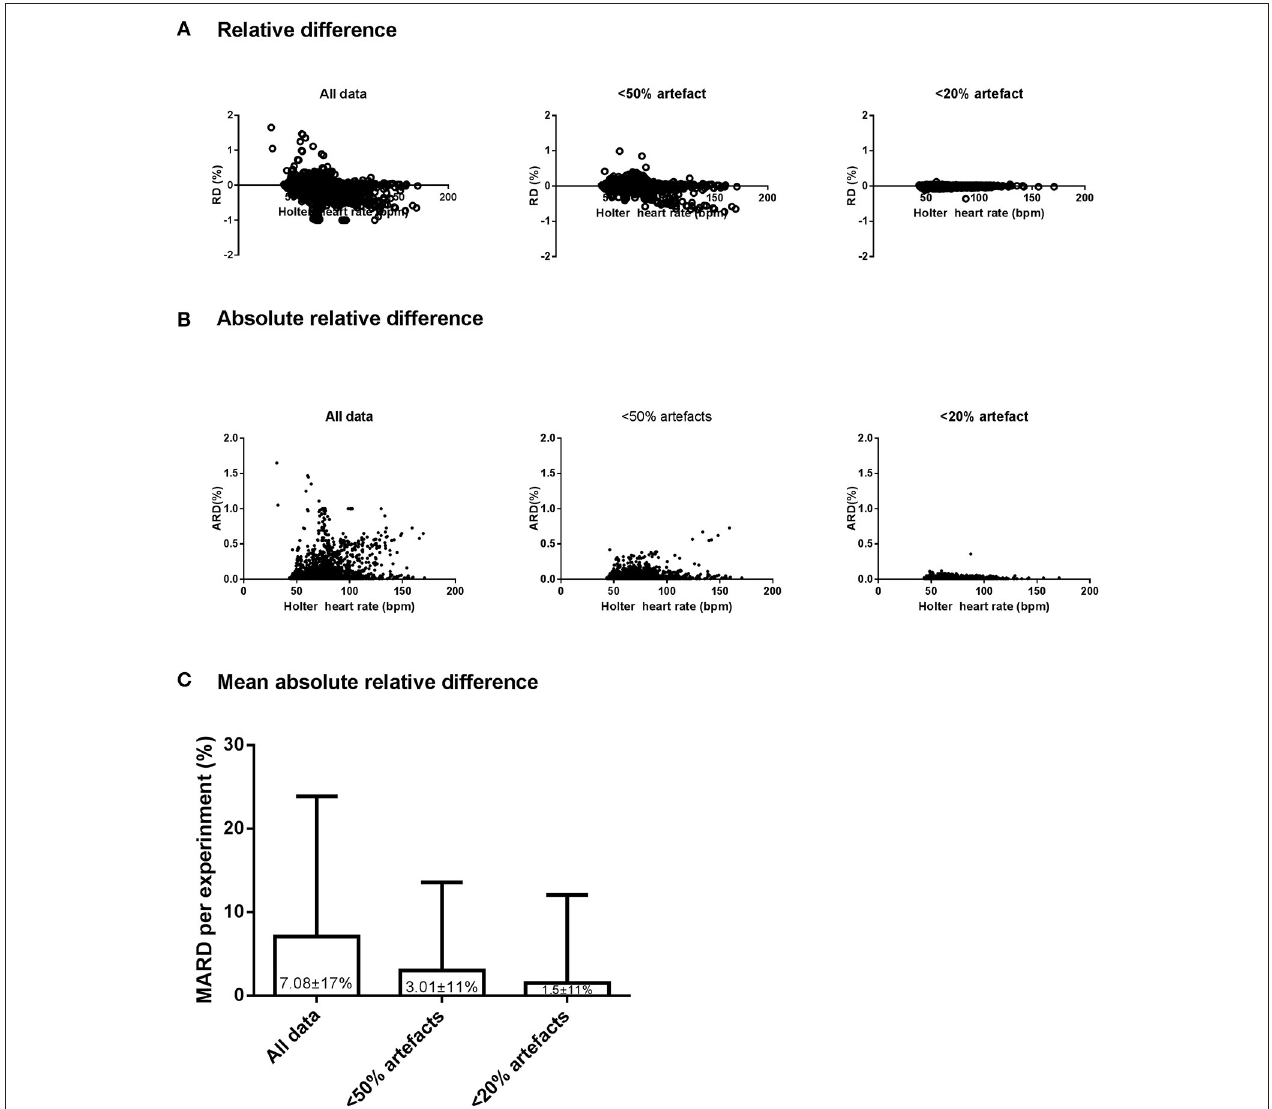
FIGURE 4 | Accuracy, precision, and reliability of the EQ02 HR measurements. The distribution, as a function of Holter values, of the relative difference (RD, A ) and absolute RD (B) between each EQ02 HR measurement and its corresponding Holter HR value, for all data, and filtered data containing < 50% and < 20% artifacts respectively. (C) : MARD between EQ02- and Holter- derived HR